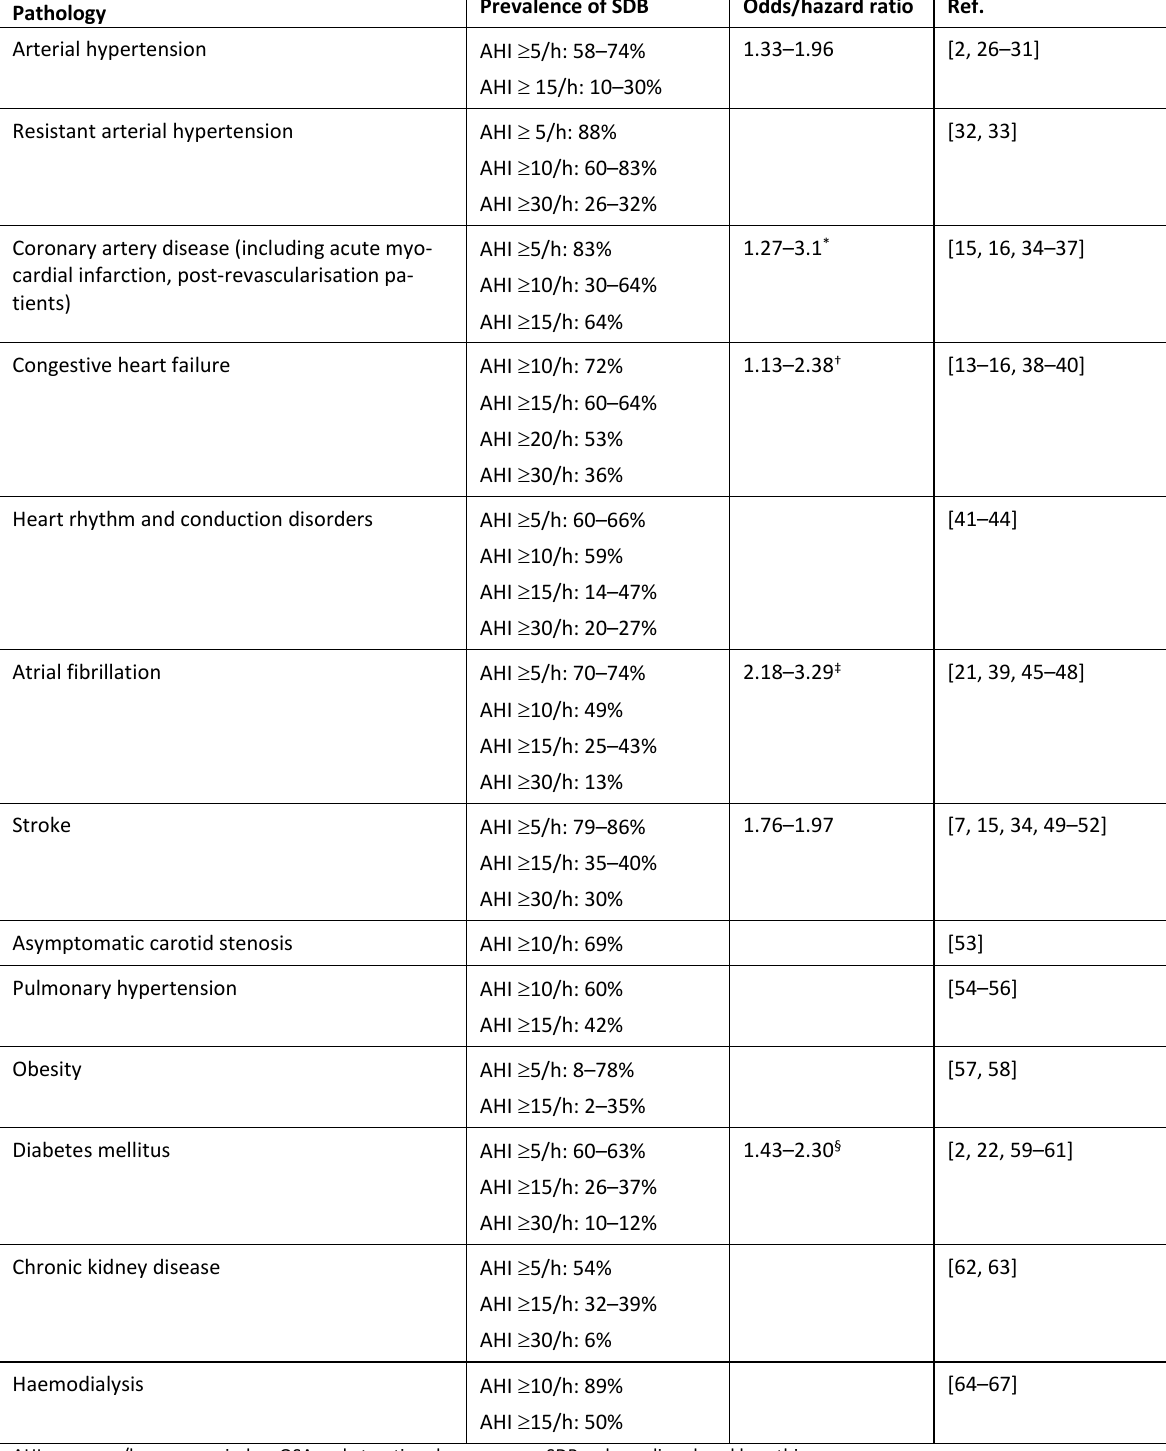
Table 1: The prevalence of SDB in various cardiovascular diseases and co-morbidities and adjusted odds/hazard ratios for the presence of these diseases in patients with SDB, mainly